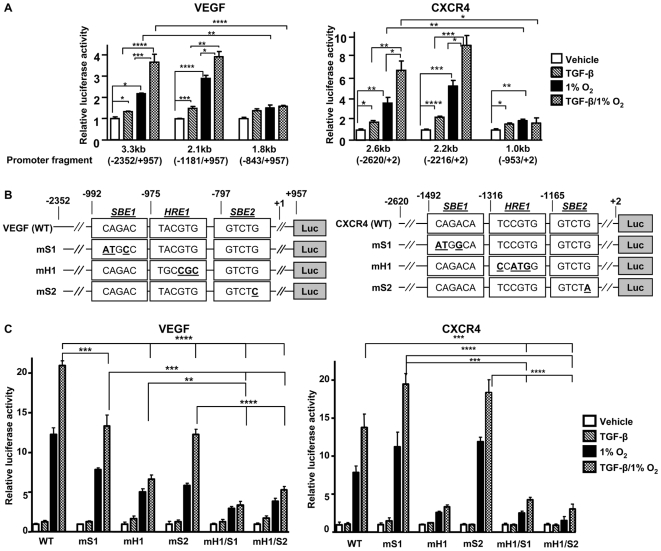
Hypoxia and TGF-β increase VEGF and CXCR4 transcription through proximal promoter response elements.(A) HepG2 cells were transfected with pGL3 plasmids containing full-length for 5′-deleted fragments of the human VEGF or CXCR4 promoter and the phRL-CMV plasmid. Cells were treated ± TGF-β (5 ng/mL) ± 1% O2 during 24 h before measuring dual-luciferase activity. Results are expressed as the mean ± SEM (n = 3) of the relative luciferase activity, analyzed using an unpaired Student's t test. (B) Schematic representation of wild-type (WT), HRE-mutant (mH1) and SBE-mutant (mS1 or mS2) VEGF and CXCR4 promoters. One to three nucleotides (underlined, bold letters) within HRE and SBEs were substituted as indicated. (C) HepG2 cells were transfected with pGL3 plasmids containing a wild-type VEGF or CXCR4 promoter or promoters with mutations to the HRE or SBE and the phRL-CMV plasmid. Cells were treated ± TGF-β (5 ng/mL) ± 1% O2 during 24 h before measuring dual-luciferase activity. Results are expressed as the mean ± SEM (n = 3) of the relative luciferase activity, analyzed using an unpaired Student's t test. * P<0.05, ** P<0.01, *** P<0.005, **** P<0.001.